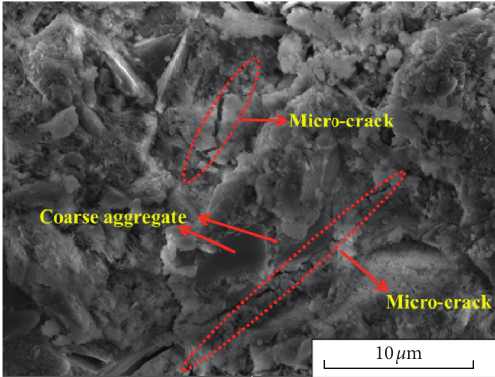
Figure 14: Surface topography of the reference